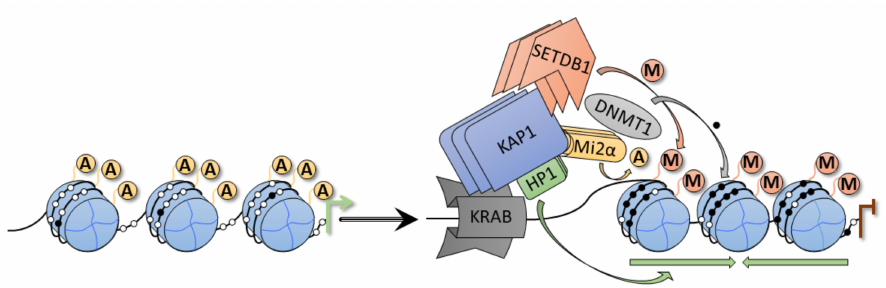
Figure 2. Repressive complex with the participation of a KRAB-ZFP factor. The repression complex contains the scaffold protein KAP1, H3K9 methyltransferase SET Domain Bifurcated 1 (SETDB1), heterochromatin protein 1 (HP1), and repressive Nucleosome Remodeling Deacetylase (NuRD) complex with Mi2 α histone deacetylase. In certain cell types, the complex may also interact with DNA methyltransferase. These protein partners cooperatively inhibit transcriptional activity and promoter heterochromatization of the locus recognized by the zinc finger domain within an interacting KRAB- ZFP factor. A—histone acetylation, M—H3K9me3, white circles—unmethylated cytosines, black circles—methylated